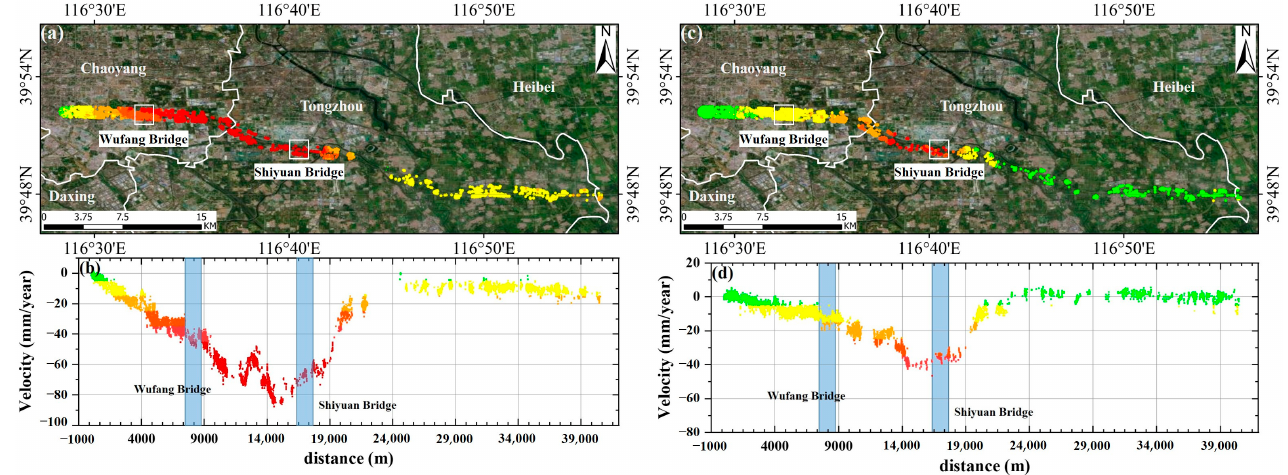
Figure 15. ( a , b ). Subsidence rate scenario for G1 between January 2018 and March 2020. ( c , d ). Sub- sidence rate scenario for G1 between February 2020 and April